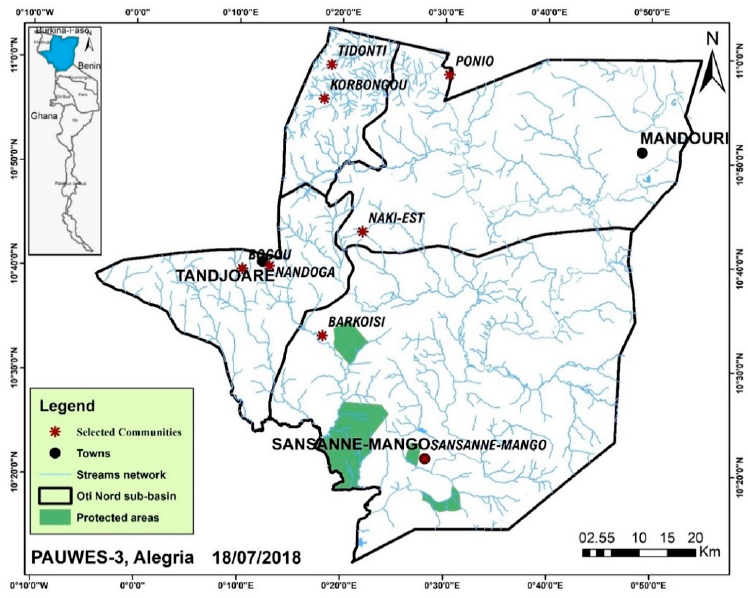
Figure 1. Map of the Oti River Basin and Oti Nord sub-basin.